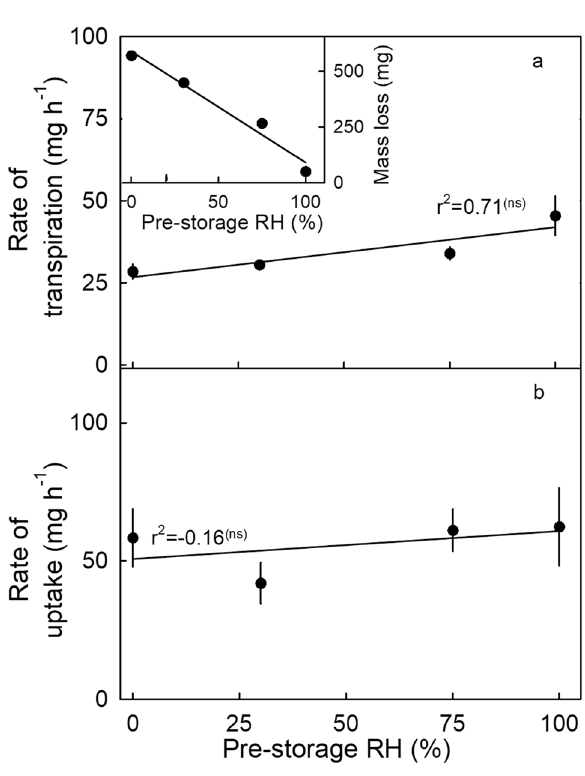
Figure 9. Effect of relative humidity (RH) during a 24 h pre-storage period on ( a ) the rate of transpiration (main graph) and cumulative mass loss (inset) and on ( b ) the rate of uptake of ‘Clery’